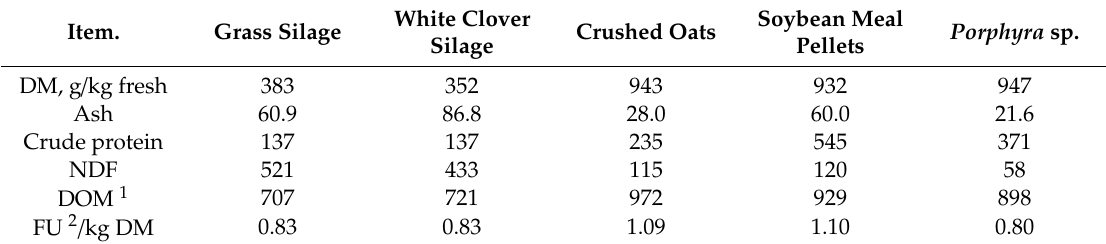
Table 1. Average chemical composition (g / kg DM) of diet ingredients. Item. Crushed Oats Porphyra sp.